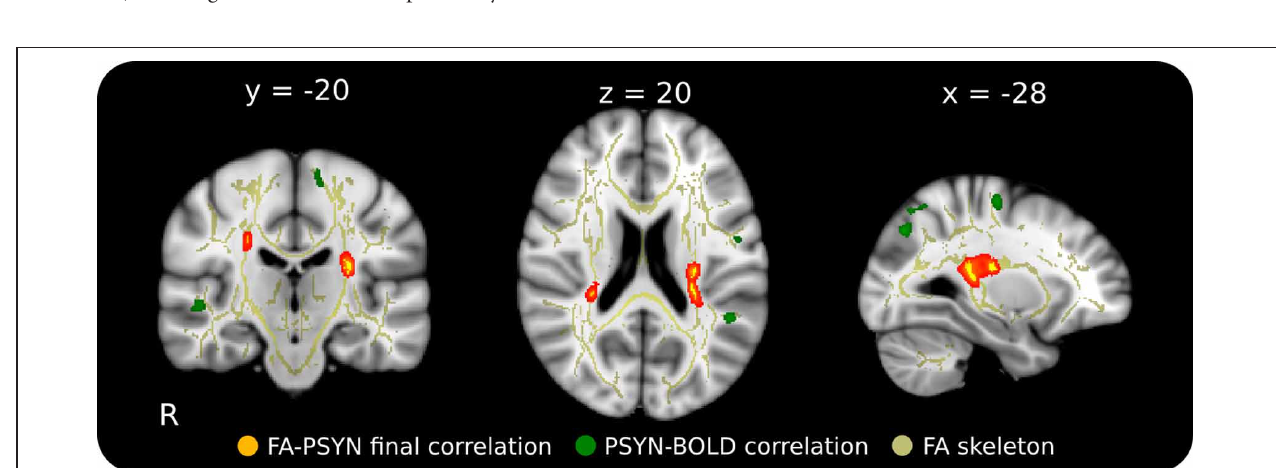
and final synchronization ( p < 0 . 05, corrected for multiple comparisons); Green: functional correlation between synchronization performance and BOLD across the 5 days of the experiment ( p < 0 . 001, cluster corrected); Yellow: mean FA skeleton (FA > 0.25). Significant voxels in the FA skeleton were thickened and overlaid on the ICBM 152 T1 for